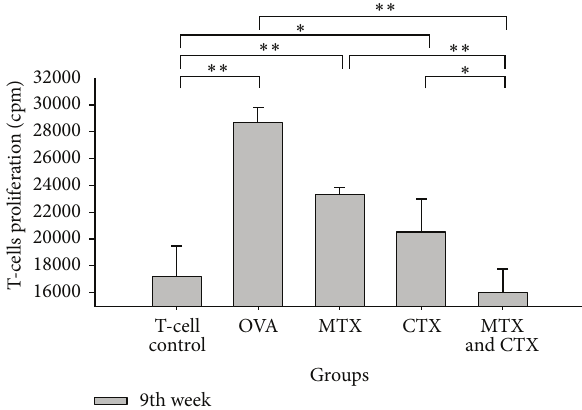
Figure 6: Stimulation index of mixed lymphocytes stimulated by BMDC on 9th week. Data were representative of 3 independent experiments ( ∗ 𝑃 < 0.05 , ∗∗ 𝑃 < 0.01